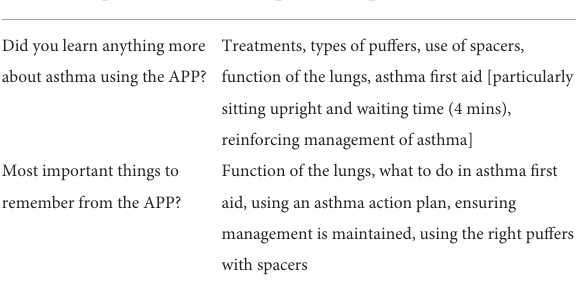
TABLE 4 Carers opinion of the Asthma